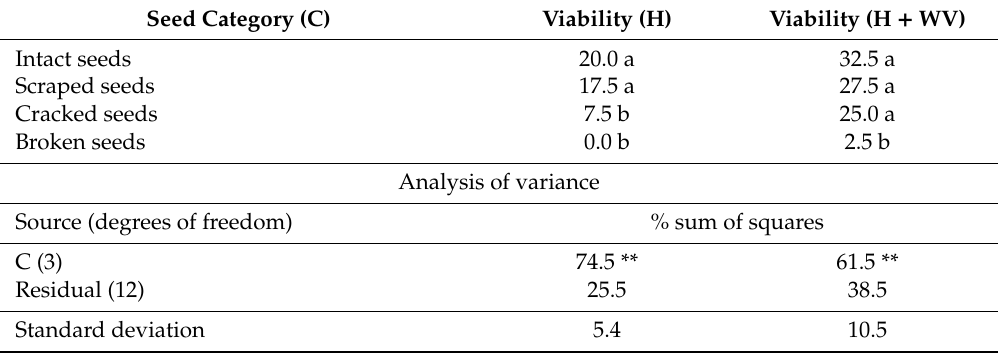
Table 4. E ff ects of the seed category on the viability (%) of the seeds considering only the healthy seeds (H) and considering both the healthy and viable but with weak tissues (H + WV). Mean